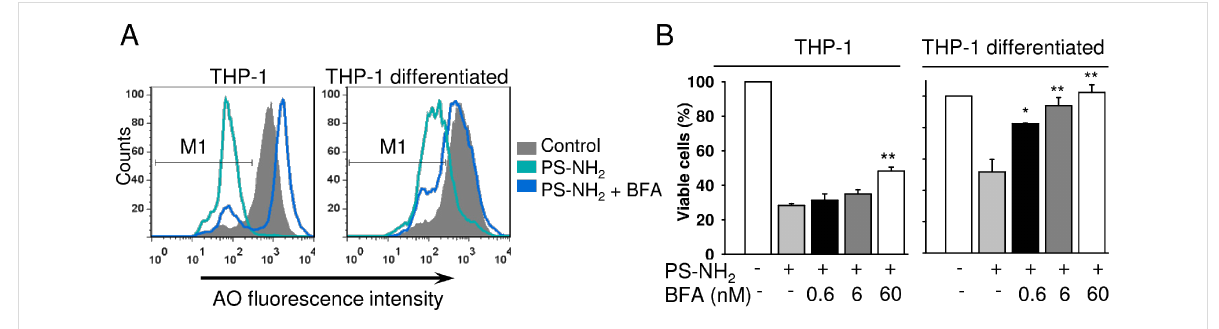
Figure 5: Inhibition of vacuolar ATPase by bafilomycin A1 antagonizes the toxic effect of PS-NH 2 nanoparticles. (A) Analysis of lysosomal permeabi- lization of cells stimulated with PS-NH 2 (100 µg/mL) with or without bafilomycin A1 (BFA, 6 nM) for 72 h. After treatment with nanoparticles, cells were stained with acridine orange (AO) and analyzed by flow cytometry. M1 gating was used to assess the number of AO low cells with leaky lysosomes. (B) Analysis of cell viability. Cells were treated as in (A) and analyzed by XTT assay. Results are mean ± SEM, n = 3, * p < 0.05, ** p < 0.01.